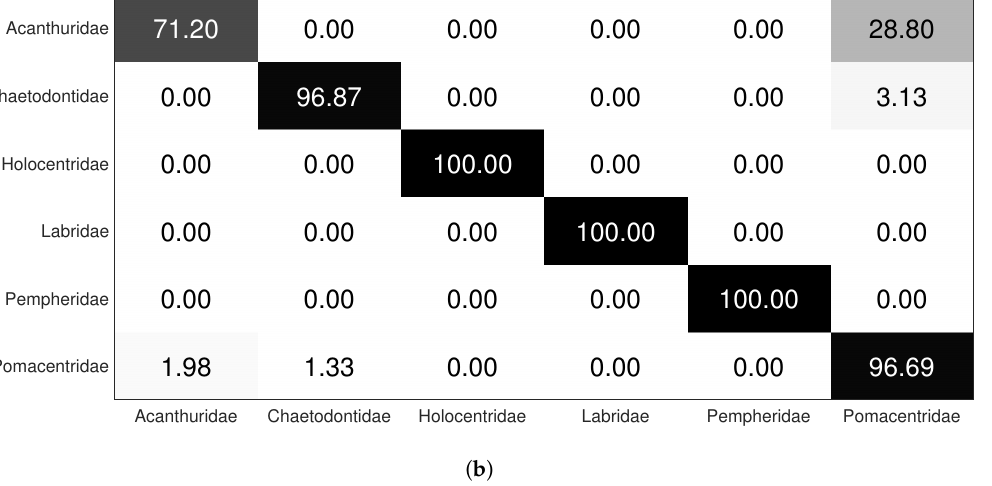
Figure 12. Root node confusion matrix for the LCF-15 dataset: ( a ) without data augmentation and ( b ) with targeted data augmentation.